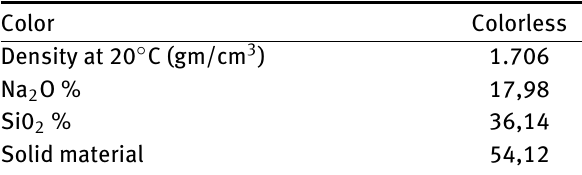
Table 7: Properties of sodium silicate